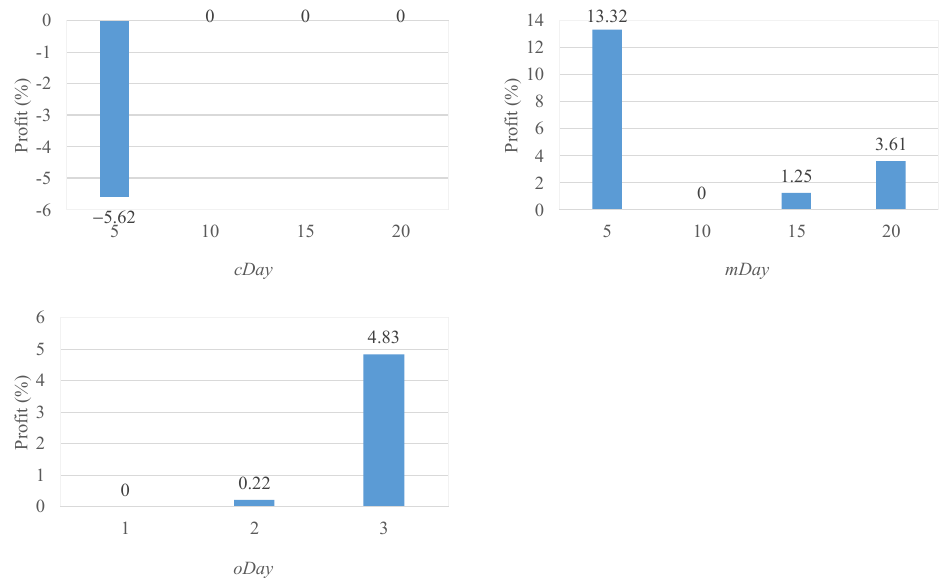
Figure 9. Profits of different parameter settings on two-year dataset (2011–2012).